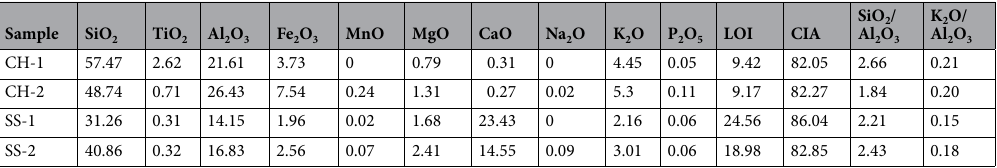
Table 1. Major chemical compositions of the ash beds